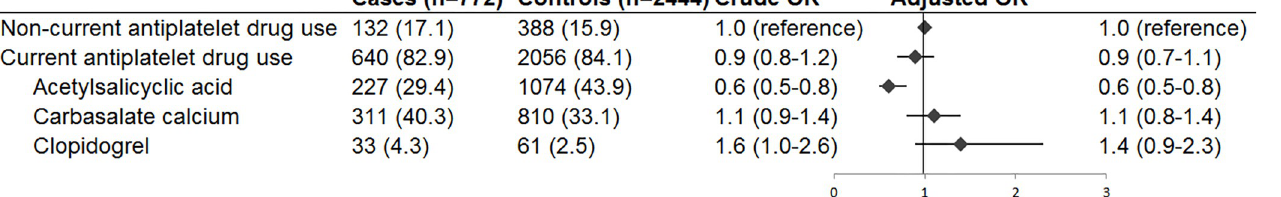
Fig 2. Current use of antiplatelet drugs, acetylsalicylic acid, carbasalate calcium or clopidogrel and out-of-hospital cardiac arrest risk compared with no current use of any antiplatelet drugs. Not included in the figure: current users of other antiplatelet monotherapy (e.g., dipyridamole, ticlopidine) among cases (n = 9, 1.2%) and controls (n = 42, 1.7%), and current users of � 2 antiplatelet drugs among cases (n = 60, 7.8%) and controls (n = 69, 2.8%). Abbreviations: CI, confidence interval; OR, odds ratio. Numbers in table are number (%) unless indicated otherwise. Error bars denote 95% confidence interval. Numbers are number (%) unless indicated otherwise.